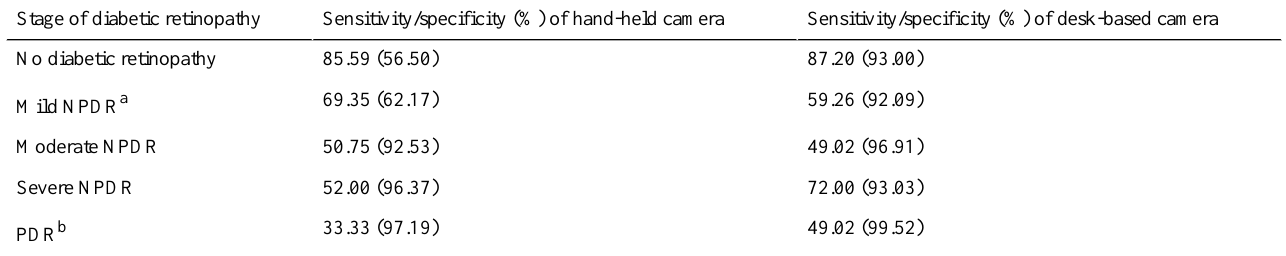
Table 3. Diagnostic accuracy of diabetic retinopathy screening by instrument types across different diabetic retinopathy stages in 6 selected peripheral hospitals in Bangladesh from July 2017 to June